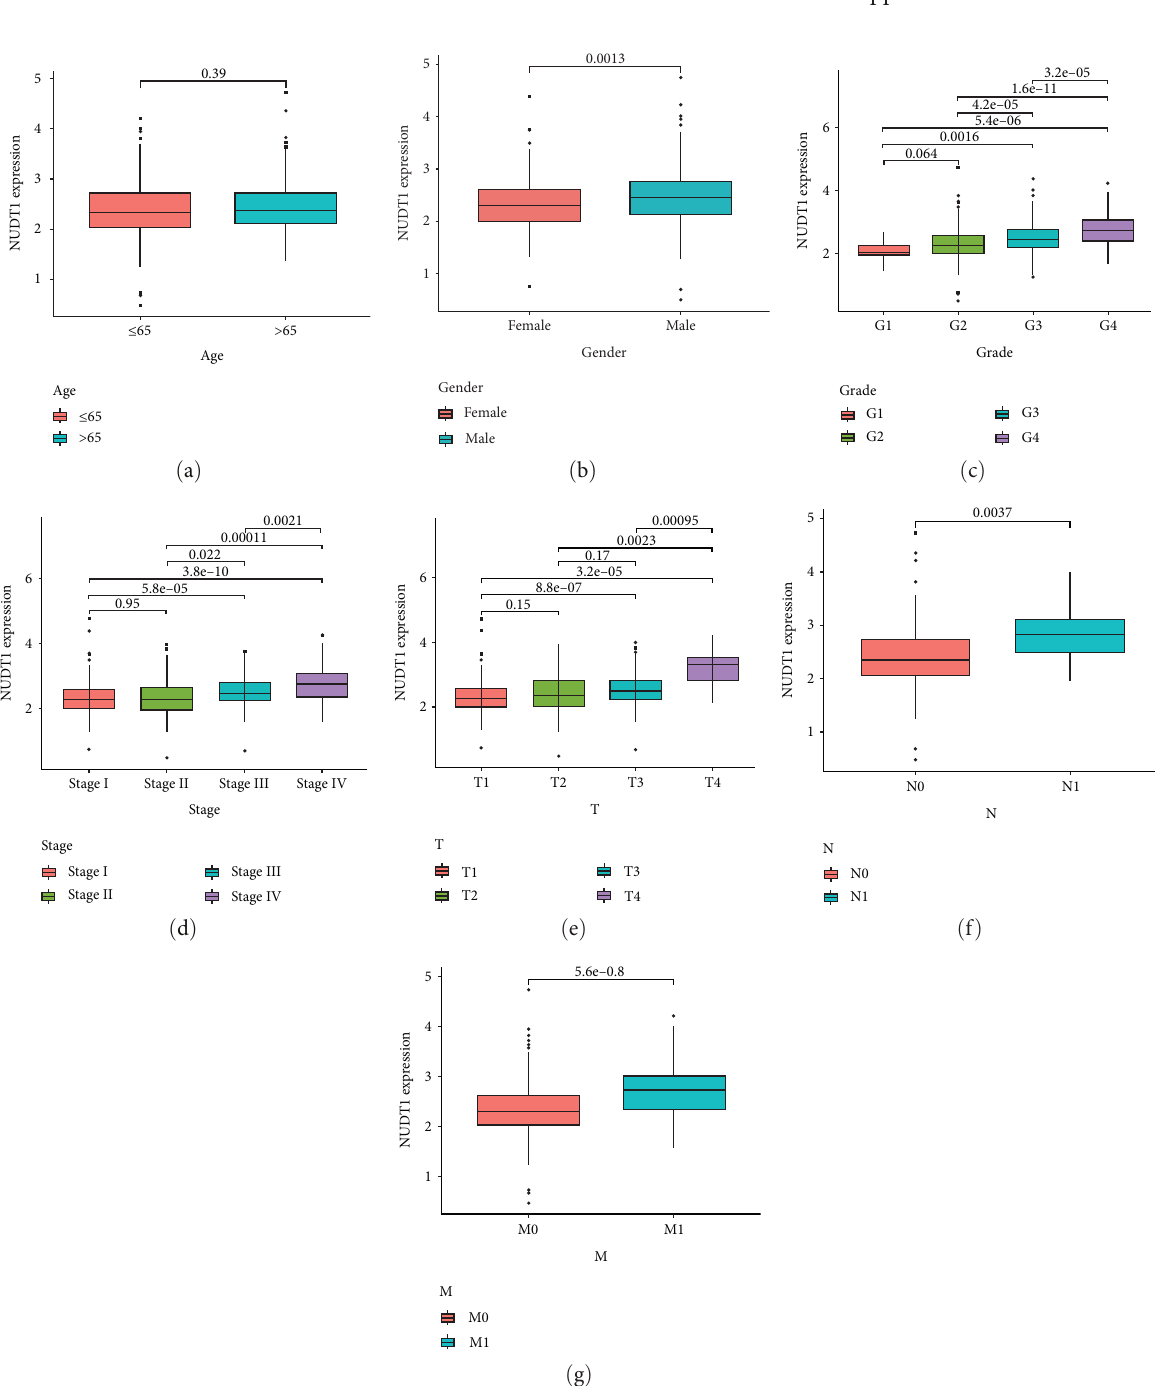
F IGURE 2: Evaluation and analysis of the clinicopathological features based on NUDT1 expression. The NUDT1 mRNA expression level was expressed for the patient clinicopathological features of (a) age, (b) gender, (c) grade, (d) stage, (e) T stage, (f) N stage, and (g) M